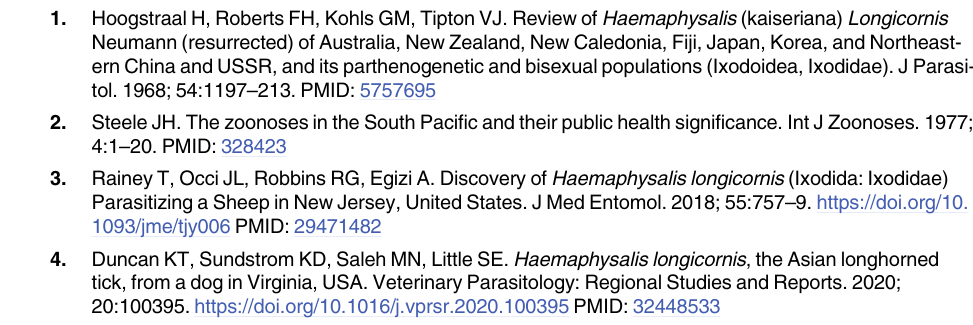
S10 Table. KEGG pathway analysis of differentially expressed proteins in midguts. GeneR- atio: the number of uploaded proteins enriched in the pathway / the number of uploaded pro- teins; BgRatio: the number of proteins in this pathway in the database / all the numbers in the database; p-value: calculated by constructing a 2 × 2 contingency table based on the above two data; p adjust and q-value are the corrected p-values. S11 Table. KEGG pathway analysis of differentially expressed proteins in ovaries. GeneRa- tio: the number of uploaded proteins enriched in the pathway / the number of uploaded pro- teins; BgRatio: the number of proteins in this pathway in the database / all the numbers in the database; p-value: calculated by constructing a 2 × 2 contingency table based on the above two data; p adjust and q-value are the corrected p-values. S12 Table. KEGG pathway analysis of differentially expressed proteins in Malpighian tubules. GeneRatio: the number of uploaded proteins enriched in the pathway / the number of uploaded proteins; BgRatio: the number of proteins in this pathway in the database / all the numbers in the database; p-value: calculated by constructing a 2 × 2 contingency table based on the above two data; p adjust and q-value are the corrected